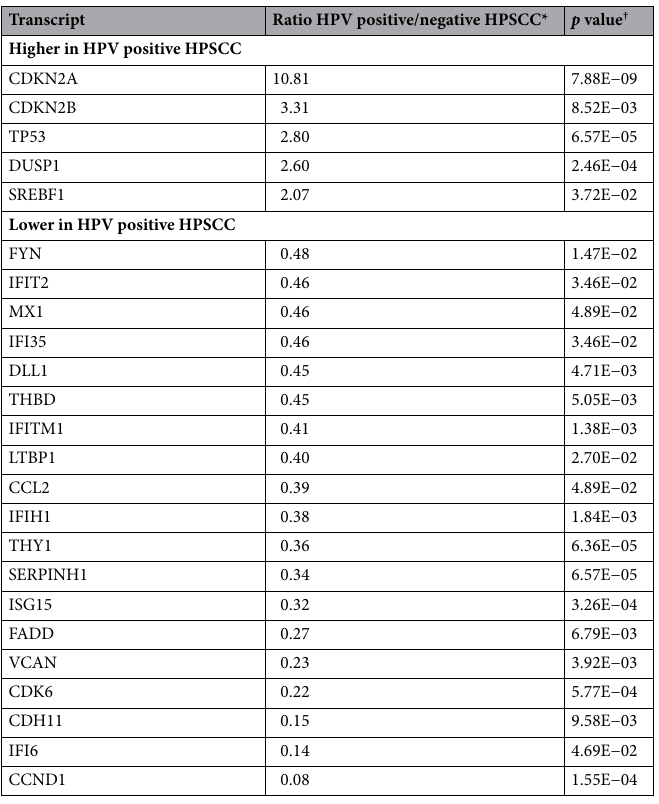
Table 2. Transcripts with > twofold and significant difference in expression between HPV positive and negative HPSCC. *2-log ratios transformed into linear ratios. † Adjusted for false discovery rate.